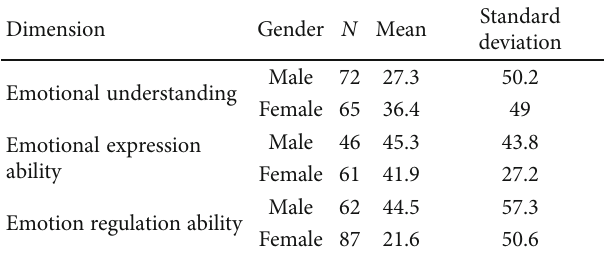
Table 1: Di ff erences in emotional understanding ability in terms of